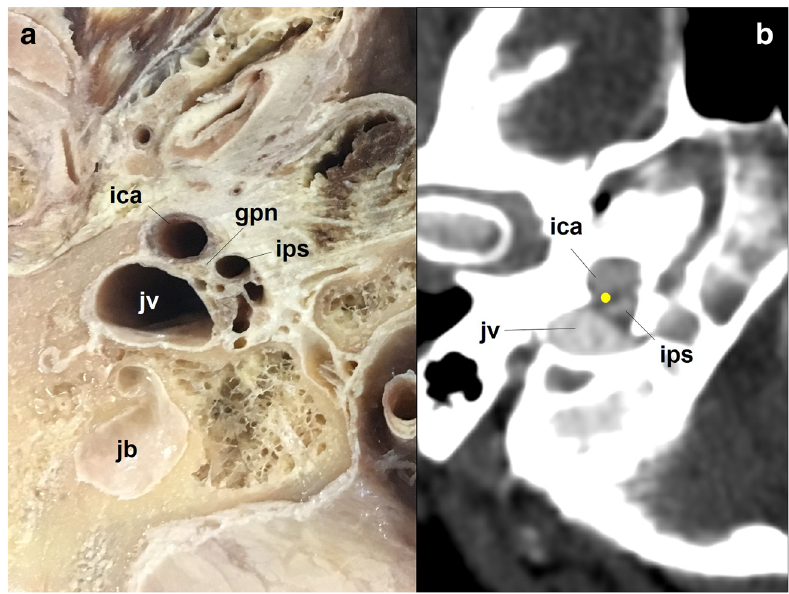
Fig. 5 The glossopharyngeal nerve (gpn) at the jugular foramen. a Cadaveric section at the level of the skull base; view from below. The glossopharyngeal nerve exits the skull close to the inferior petrosal sinus (ips), the internal carotid artery (ica) and the jugular vein (jv). jb: jugular bulb. b Corresponding axial neck CT scan at the extracranial verge of the jugular foramen; right temporal bone, soft tissues window. The glossopharyngeal nerve is represented with a yellow